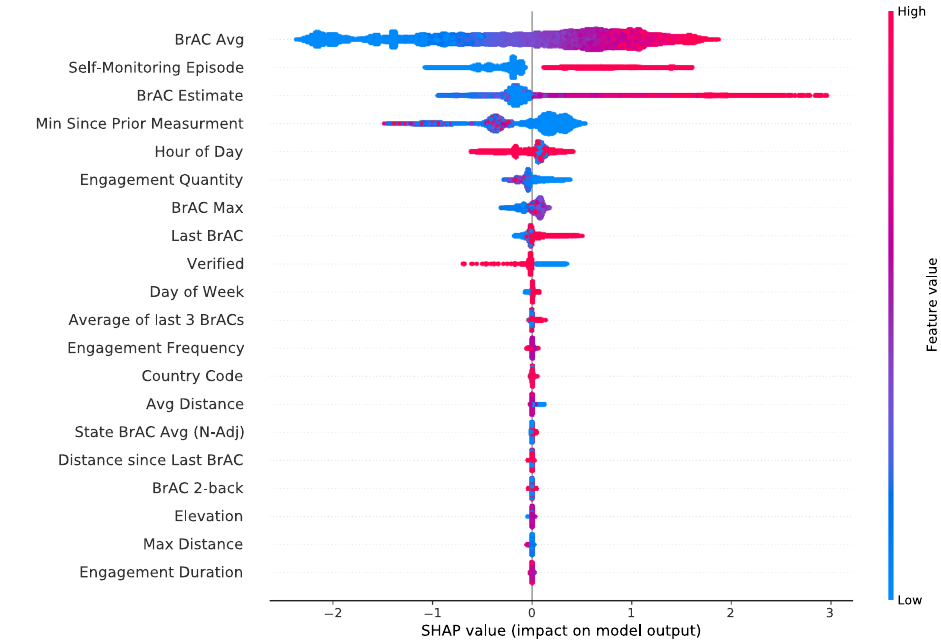
Fig. 3 Feature importances. SHAP values quantify the relative impact of each feature on model performance in the hold-out test set of separate users. This fi gure depicts the most important features, whereby the horizontal location shows whether the feature is associated with a lower (left) versus higher (right) predicted probability of a high BrAC ≥ 0.08 g/dL) across all observations in the test set. The color demonstrates the directionality of the association. These analyses reveal a prominent role for habitual behavior patterns, self-monitoring, engagement, time of day, and human-in-the-loop features such as self-estimations or veri fi cations. They depict secondary roles for other temporal, geographic, policy-relevant, and socioeconomic